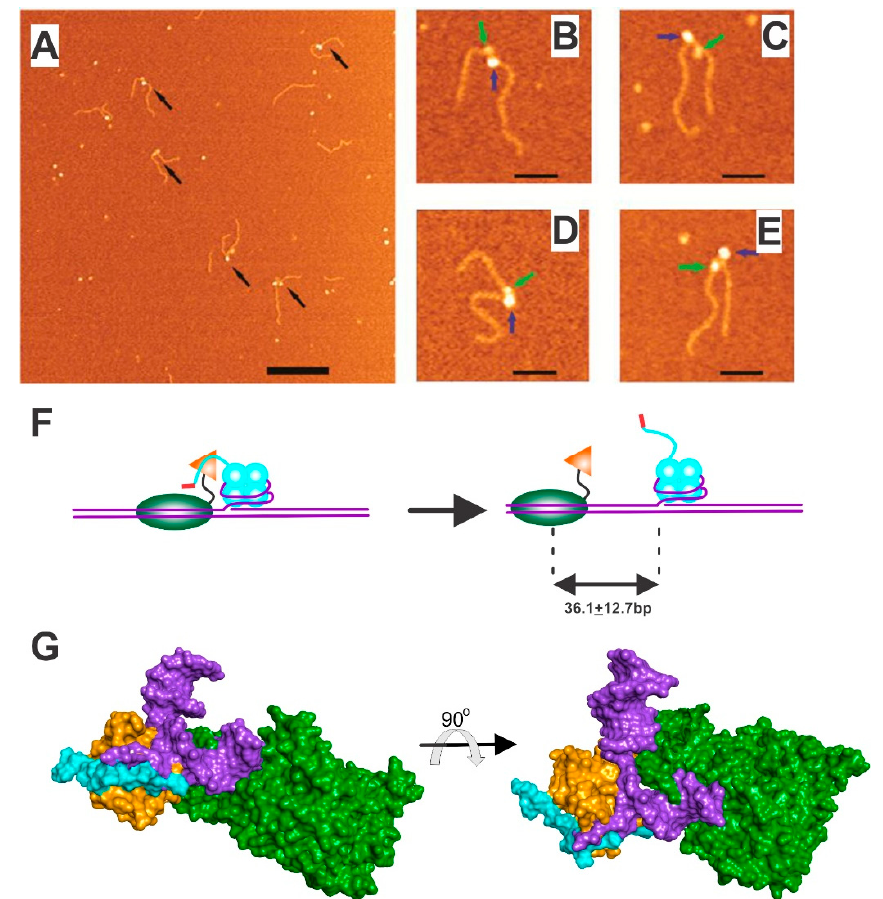
Figure 6. SSB loads RecG and remodels the helicase in the process. ( A ) Large scale atomic force microscopy image of SSB-RecG-DNA complexes. Proteins are indicated by arrows. The scale bar is 200 nm. B – E , Zoomed images of four double-blob complexes. Large (SSB) and small (RecG) blobs are indicated with blue and green arrows (scale bars 50 nm). ( F ). A model for RecG loading by SSB. SSB binds to the fork first and RecG via the linker from one monomer within the tetramer. Loading ensues, concomitant with the remodeling of the wedge domain (orange) so that only the helicase domains (green) can bind DNA. Once loaded, RecG slides, using thermal energy, on average, 36 bp ahead of the fork. ( G ). Molecular models of RecG bound to a fork (purple) and the SSB linker (cyan; a PXXP-containing ligand). The wedge domain is colored orange and helicase domains in green to match the schematic in panel F. As fork and linker binding are competitive, the cyan and purple colors overlap demonstrating that cannot occupy the same space. The two images are rotated 90 ° relative to each other to enable clear visualization. AFM images are from [43].